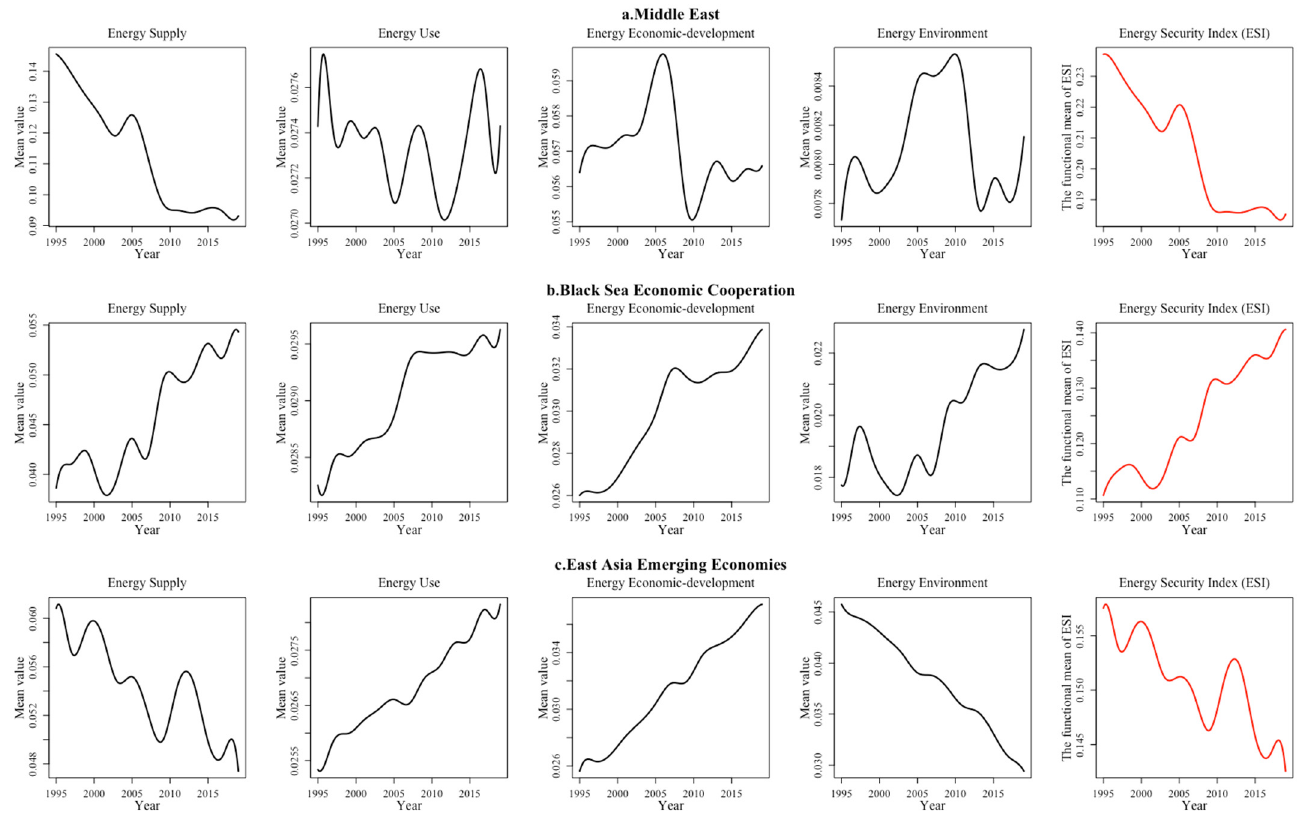
Figure 11. “Good” regional energy security system performance in four dimensions.